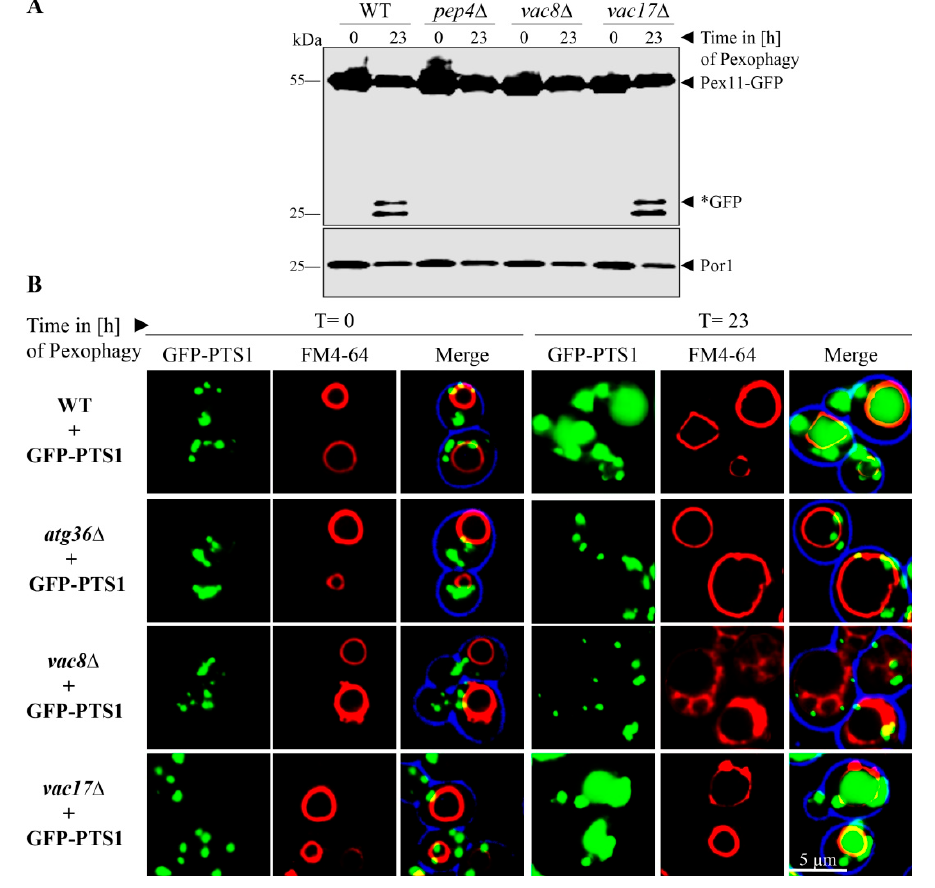
Figure 3. Vac8 is essential for pexophagy. ( A ) The possible contribution of Vac8 and Vac17 to pexophagy was monitored via the stability of the peroxisomal membrane protein Pex11, which was genetically fused to GFP. After proliferation of peroxisomes, cells were shifted to pexophagy medium. In wild-type (WT) and vac17 Δ cells, the Pex11-part of the fusion protein is degraded in the vacuole together with the rest of the organelle, while the GFP portion is largely stable (*GFP). This process is blocked in pep4 Δ and vac8 Δ cells. ( B ) Peroxisomes were labeled with the matrix protein GFP-PTS1 for fluorescence microscopy. The vacuolar membrane was stained with FM4-64. Prior to the induction of pexophagy (t = 0 h), peroxisomes are visible as green cytosolic dots, while the vacuolar lumen is devoid of these signals. At the end of the pexophagy assay (t = 23 h), some peroxisomal signals remain in the cytosol, while the vacuole of WT cells is filled with a diffuse green staining, indicating peroxisomal breakdown. The vacuole does not display GFP signals in atg36 Δ and vac8 Δ cells, indicating a defect in pexophagy.